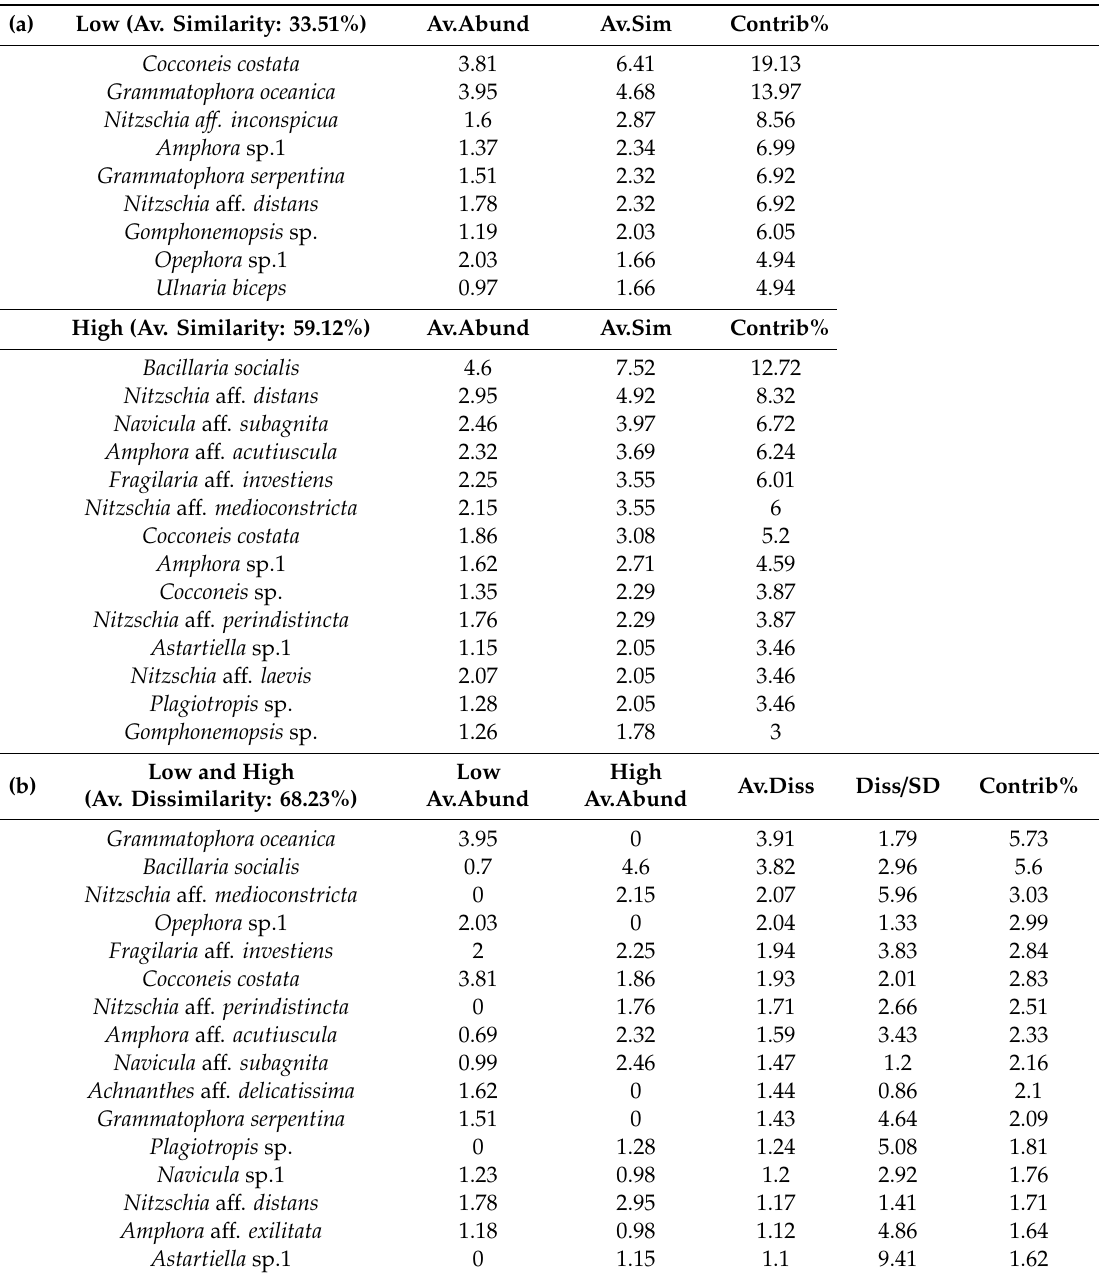
Table 4. SIMPER analysis on diatoms square-root transformed data showing the contribution of taxa to the average (Av.) Bray–Curtis similarity (a) and dissimilarity (b) between “Pressure” levels. Average (dis)similarities are indicated in